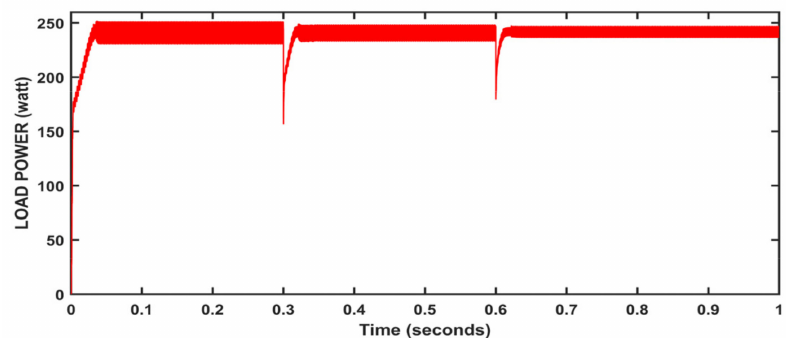
Figure 11. Algorithm performance at variable loads; T = 25 ◦ C, w = 1000 W/m 2 .